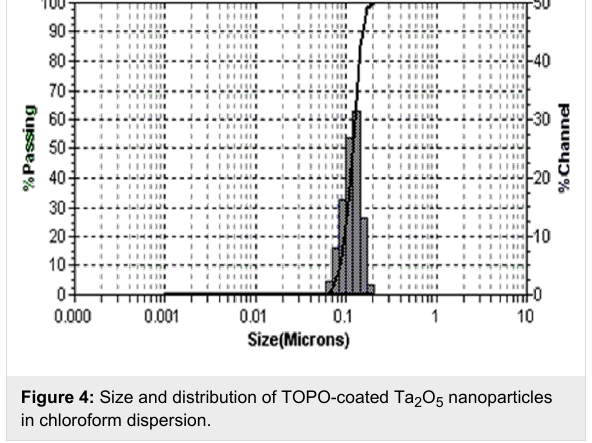
Figure 2: XRD pattern of Ta 2 O 5 nanoparticles calcined at 750 °C for 4 h.